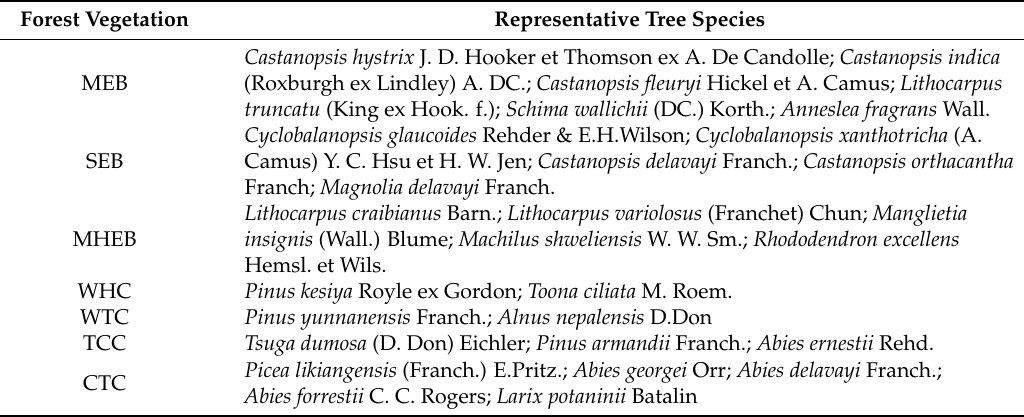
Table 2. Vegetation types and representative tree species of the